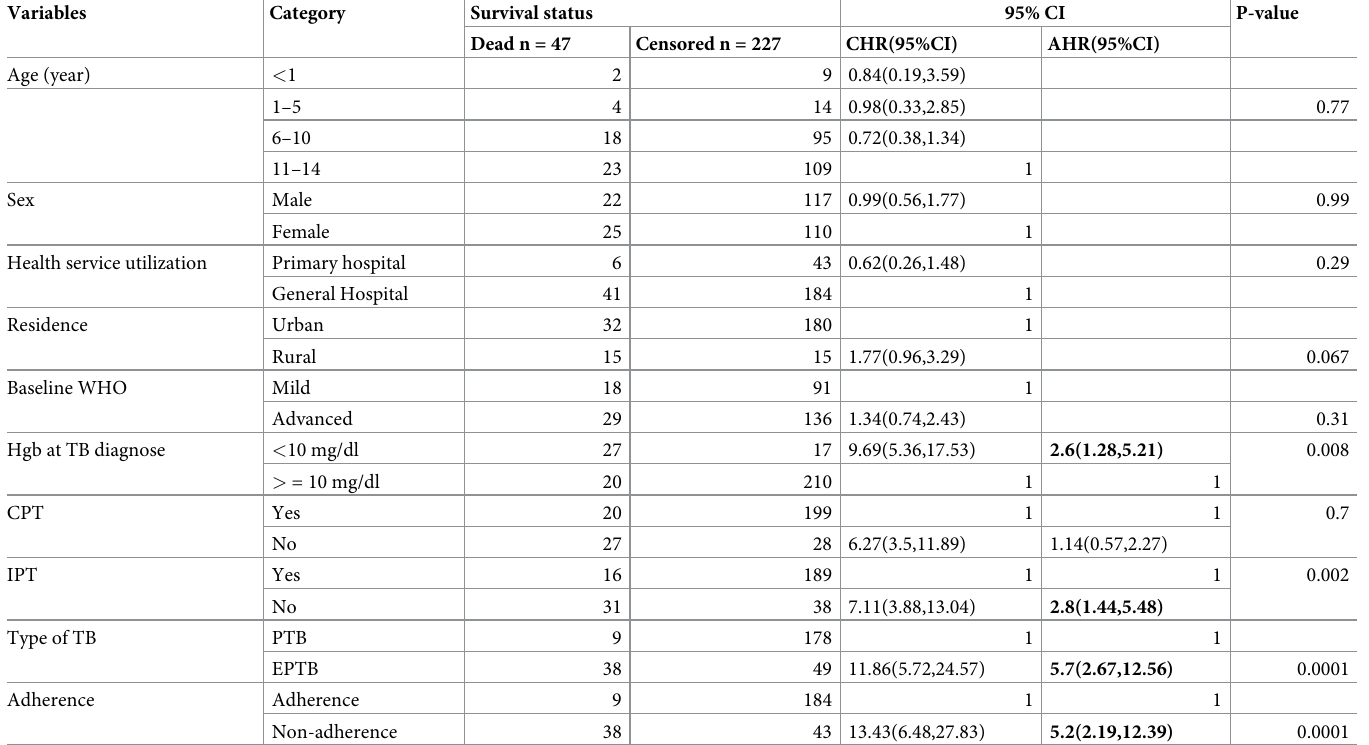
Table 6. Predictors of mortality among TB/HIV Co-infected children at public hospitals in Southern Ethiopia,